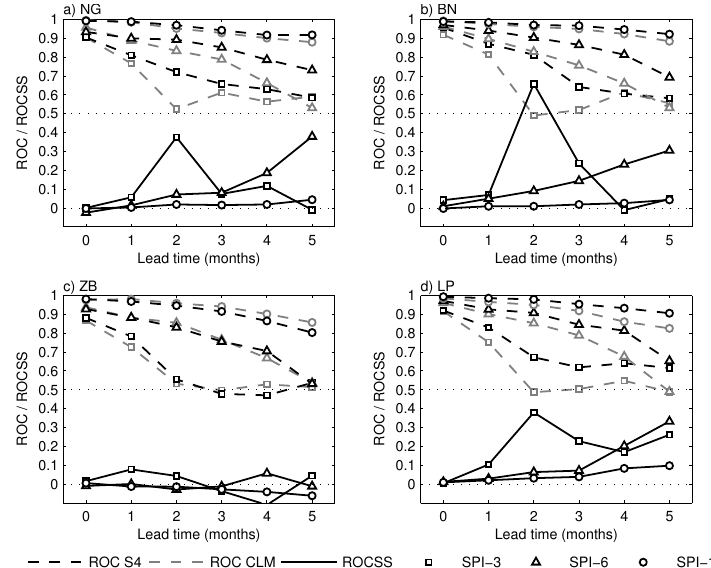
Fig. 10. Relative operating characteristic (ROC) of the SPI forecasts of S4 (dashed black) and CLM (dashed grey) and ROC skill score (ROCSS, solid black) as a function of lead time for the 3- (square symbols), 6- (triangle symbols) and 12-month (circle symbols) SPI timescale. The horizontal dotted line at 0.5 represents the minimum ROC skill and at 0 the minimum ROCSS skill (i.e. S4 outperforms